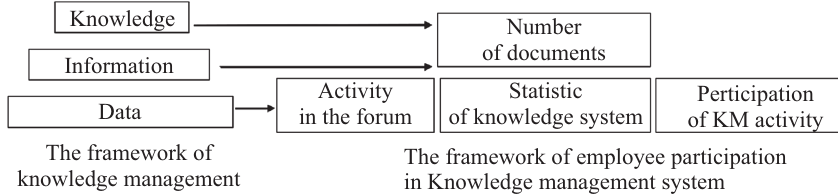
Fig. 2. The framework of Knowledge Management and Employee Participation in KMS